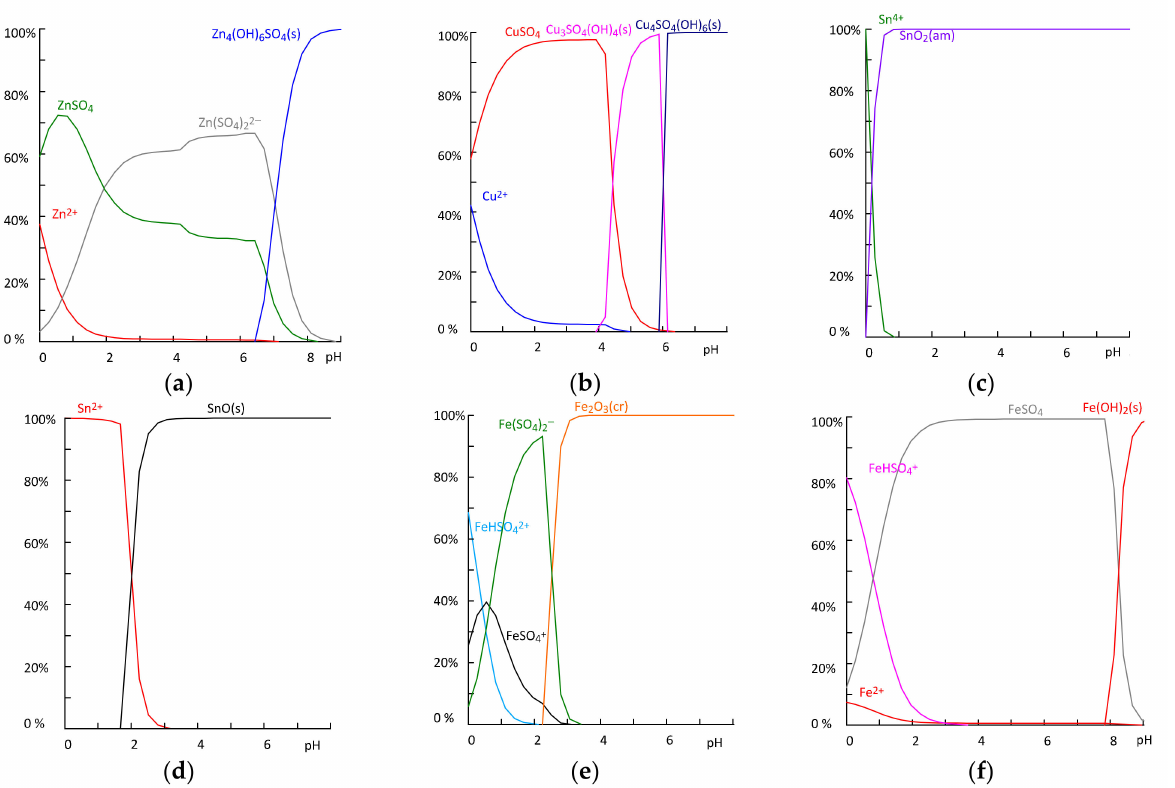
Figure 9. Predicted fraction diagrams of ( a ) [Zn] = 504 mM ( b ) [Cu] = 110 mM ( c , d ) [Sn] = 12 mM ( e , f ) [Fe] = 12 mM [Pb] = 49 mM in 1 M H 2 SO 4 solutions using MEDUSA software (Make Equilib- rium Diagrams Using Sophisticated Algorithms, 32-bit version 2010, Royal Institute of Technology, Stockholm,